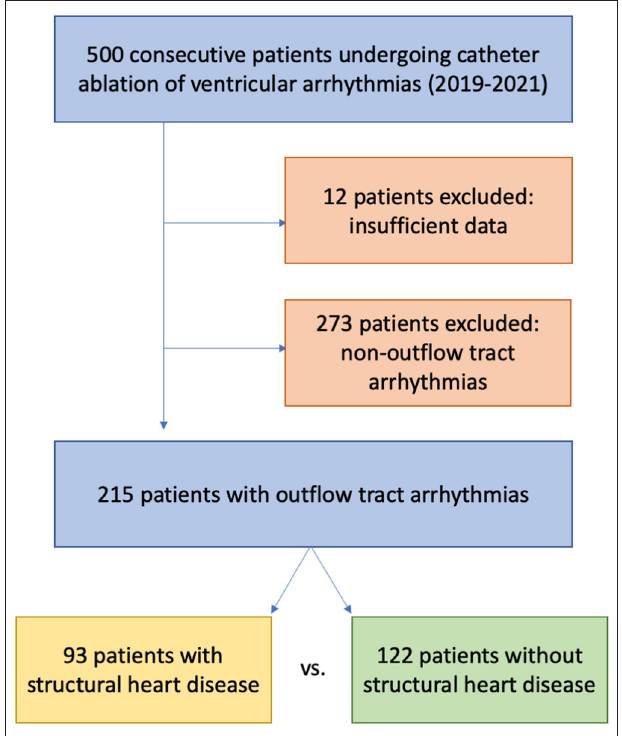
FIGURE 1 | Flow chart of the analyzed patient